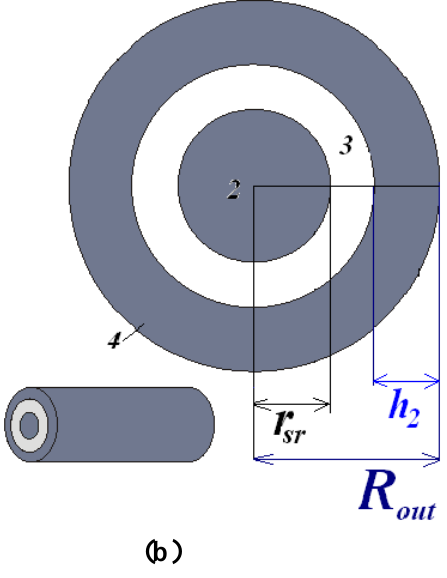
Figure 1. Schematic view of the coaxial waveguide with circular shape. ( a ) The coaxial waveguide consisting of two nano-sized metal tubes (annuli in cross sections; grey areas 2 and 4 ) with a dielectric material between them (white area 3 ) and an inner road filled with the same dielectric (white area 1 ); ( b ) The coaxial waveguide with bulk inner rod (grey area 2